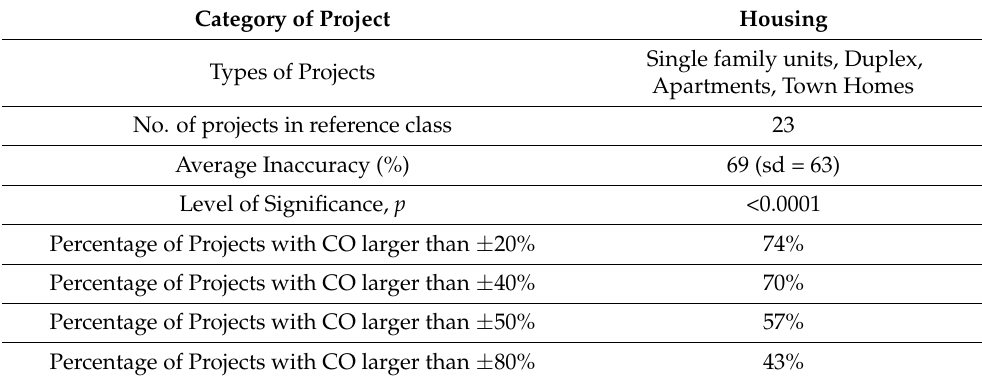
Table 2. Breakdown of cost inaccuracies in public sector DB housing